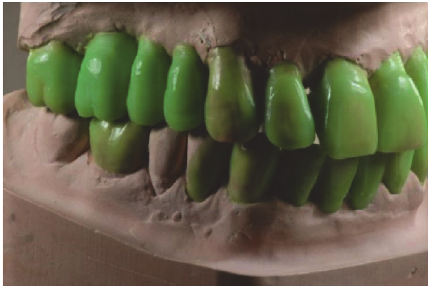
Figure 8: Diagnostic wax-up, lateral right view.